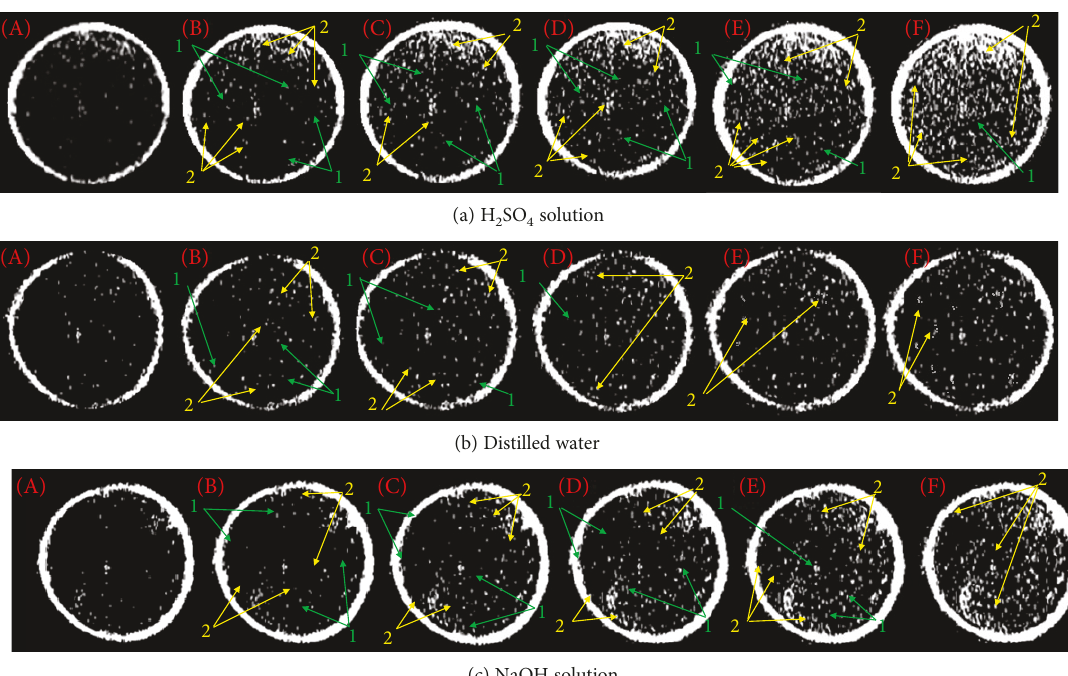
Figure 3: NMR images of specimens after treatment with di ff erent times of chemical corrosion: (A) 0 days; (B) 10days; (C) 20 days; (D) 30days; (E) 40days; and (F) 50 days.